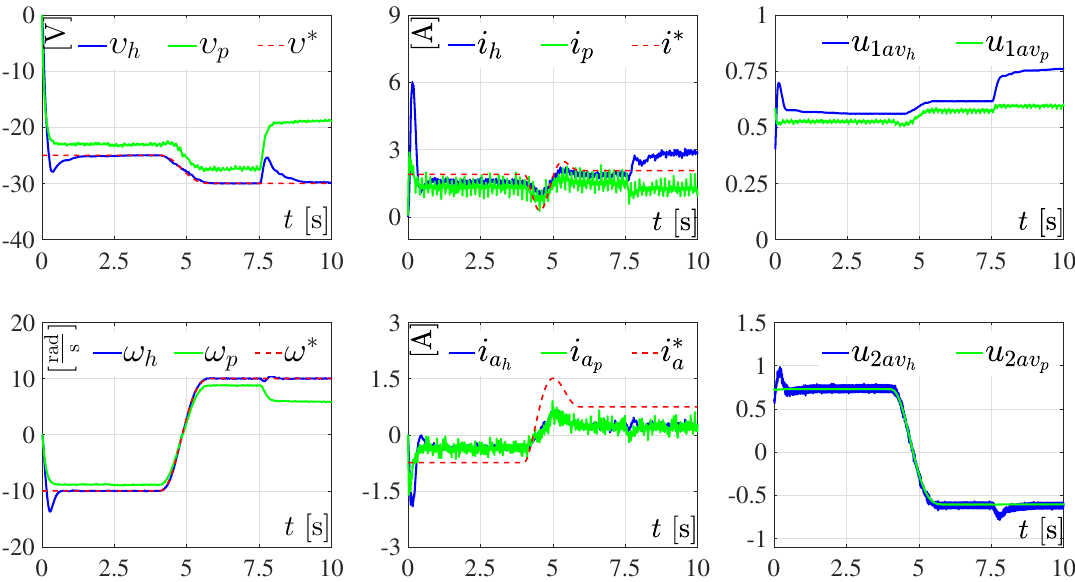
Figure 6. Experimental results in closed-loop when abrupt changes appear in E . The results related to the hierarchical controller are denoted as υ h , i h , u 1 av results of the passive controller are labeled as υ p , i p , u 1 av